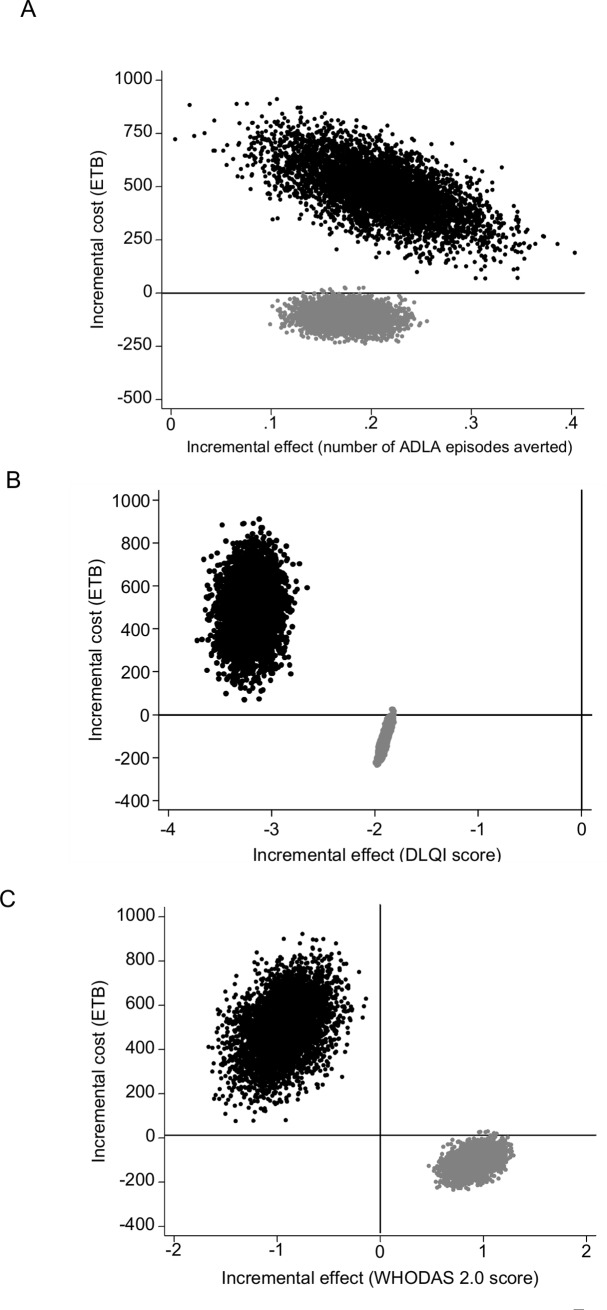
Cost-effectiveness planes for patients with monthly family income <1,000 ETB (grey circles) and monthly family income ≥1,000 ETB (black circles). The graphs show 5,000 bootstrap estimates for the number of ADLA episodes (A), DLQI (B) and WHODAS 2.0 (C). ETB, Ethiopian Birr.